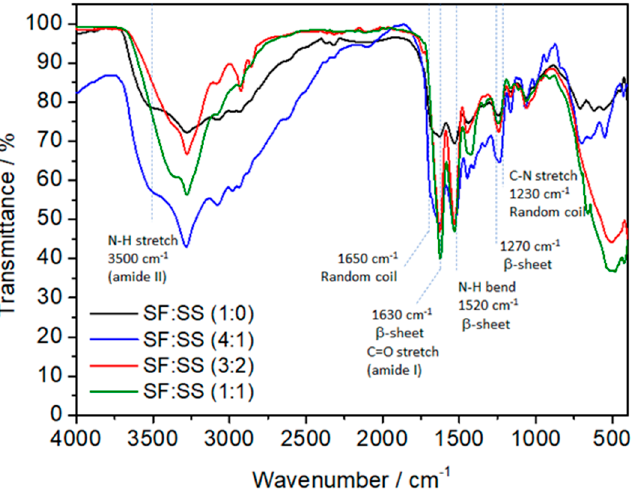
Figure 3. FTIR spectra of various SF:SS composites with different composition.